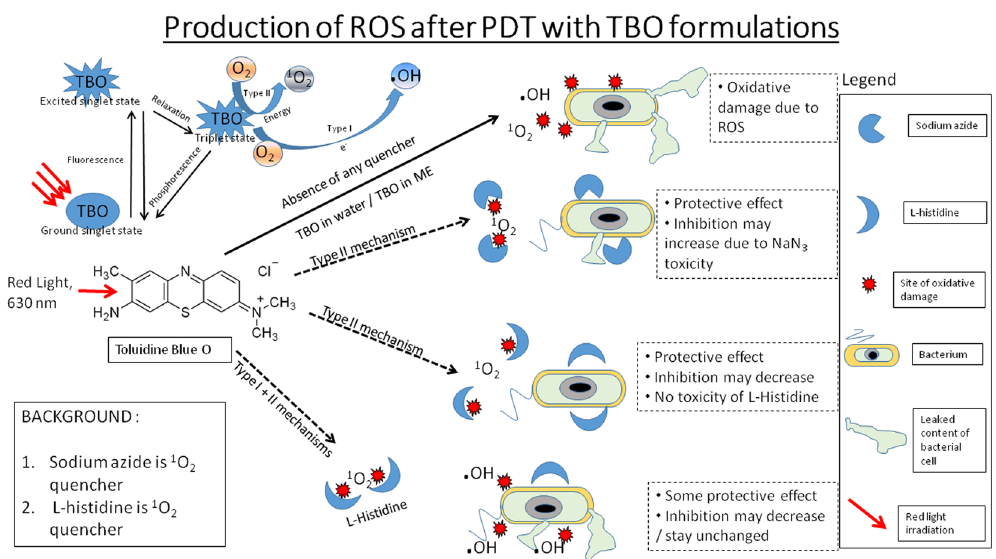
Figure 10. Antimicrobial mechanisms proposed for TBO in lipid nanoparticles. With the use of specific quenchers, it was proven that use of lipid nanoparticles for TBO encapsulation changes the mechanism of photosensitization from predominantly Type II to a combination of Type I and Type II mechanisms and therefore increases the amount of hydroxyl radicals produced to increase bacterial inactivation due to